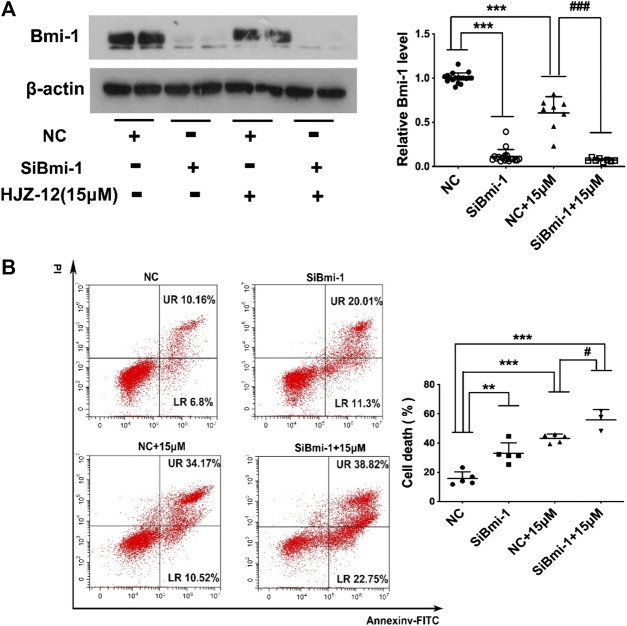
Bmi-1 mediates the apoptotic induction of HJZ-12 in BPH-1 cells. (A) Downregulation efficacy of Bmi-1 siRNA and HJZ-12 (15 μM) in BPH-1 cells as examined using Western blot, and quantitative analysis of the protein levels of Bmi-1 normalized to that of β-actin. ***p < 0.001 vs. the NC treatment group, ###p < 0.01 vs. the NC plus 15 μM HJZ-12 treatment group. (B) Effect of Bmi-1 downregulation on apoptosis of BPH-1 cells, as examined using flow cytometry analysis with Annexin V-FITC/PI staining was used to calculate the apoptotic cells. **p < 0.01 and ***p < 0.001 vs. the NC treatment group, #p < 0.05 vs. the NC plus 15 μM HJZ-12 treatment group. Columns, mean values; error bars, SD (n ≥ 5). Significance was determined using one-way ANOVA coupled with Turkey’s multiple comparisons test.